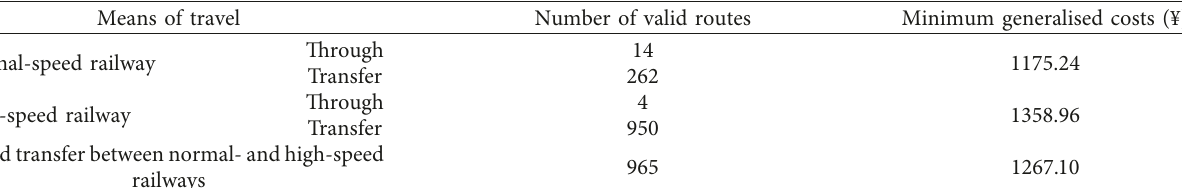
Table 7: Number of valid routes from different means.